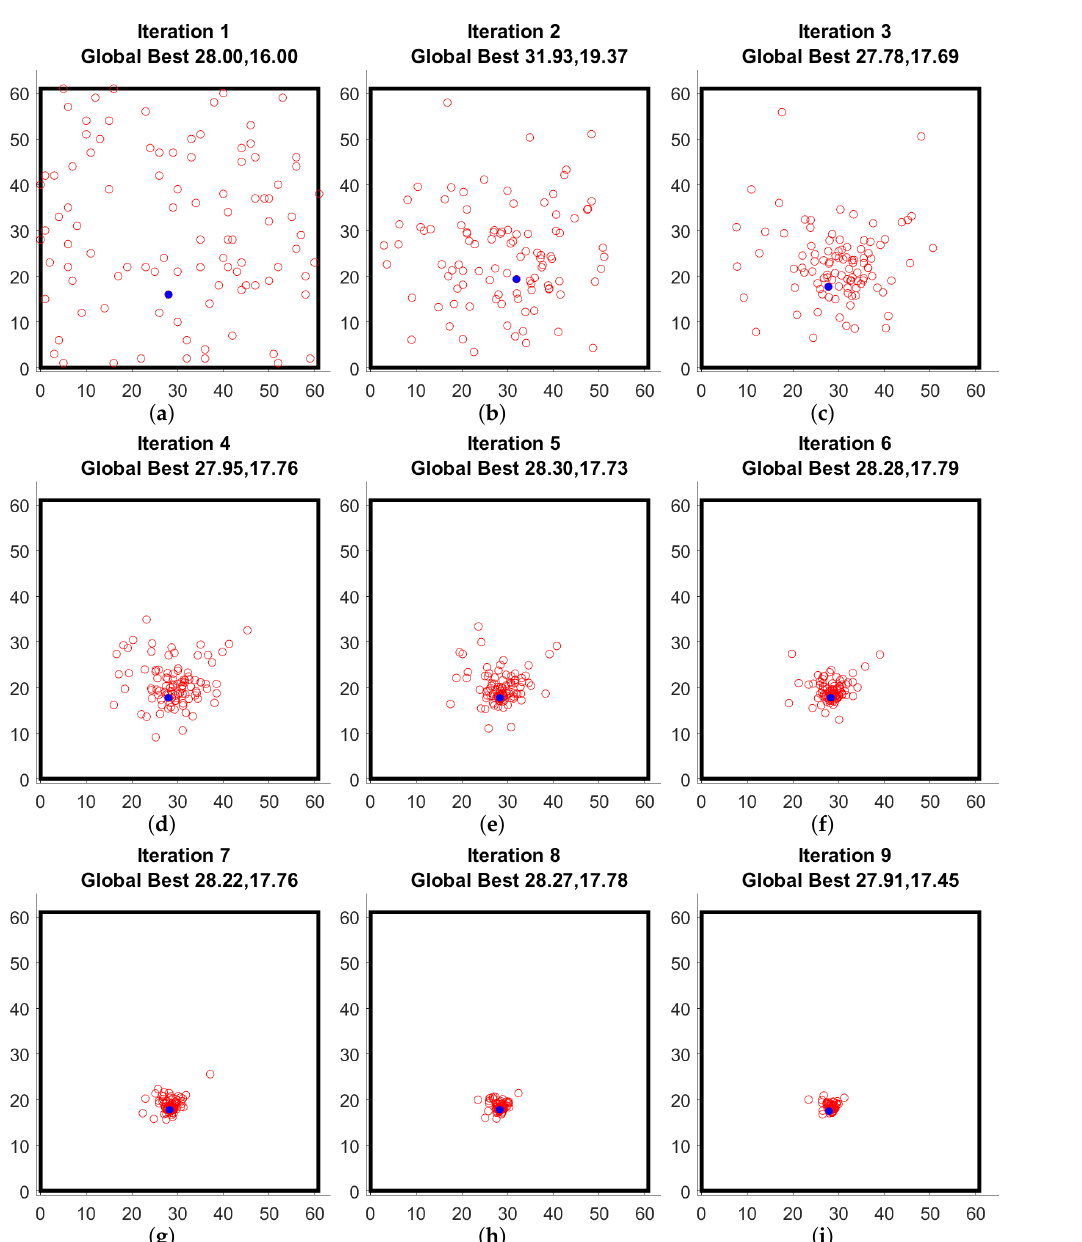
Figure 6. Swarm locations at each iteration (global best marked with a filled blue